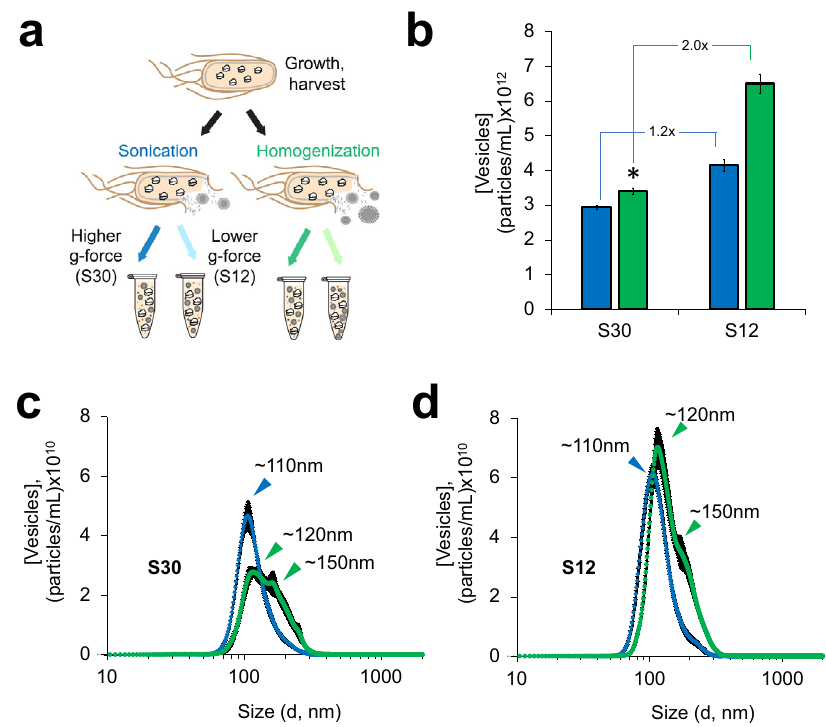
Fig. 3 Extract processing impacts vesicle size distributions and concentrations. a Illustration of extract processing conditions. Extracts were prepared in triplicate for each condition shown. b Nanoparticle Tracking Analysis (NTA) concentration analysis of vesicles in sonicated (blue) and homogenized (green) extracts. Asterisk indicates base case conditions for extract preparation. Data for ( b ) are presented as mean ± SD of n = 15 replicates (3 biologically independent extracts; each examined over 5, 1 min NTA measurements). c NTA particle size distribution of vesicles in sonicated (blue) and homogenized (green) S30 extracts. d NTA particle size distribution of sonicated (blue) and homogenized (green) S12 extracts. Data for ( c , d ) are presented as mean ± SEM of n = 15 replicates (3 biologically independent extracts; each examined over 5, 1 min NTA measurements). Source data for all panels are provided as a Source Data fi